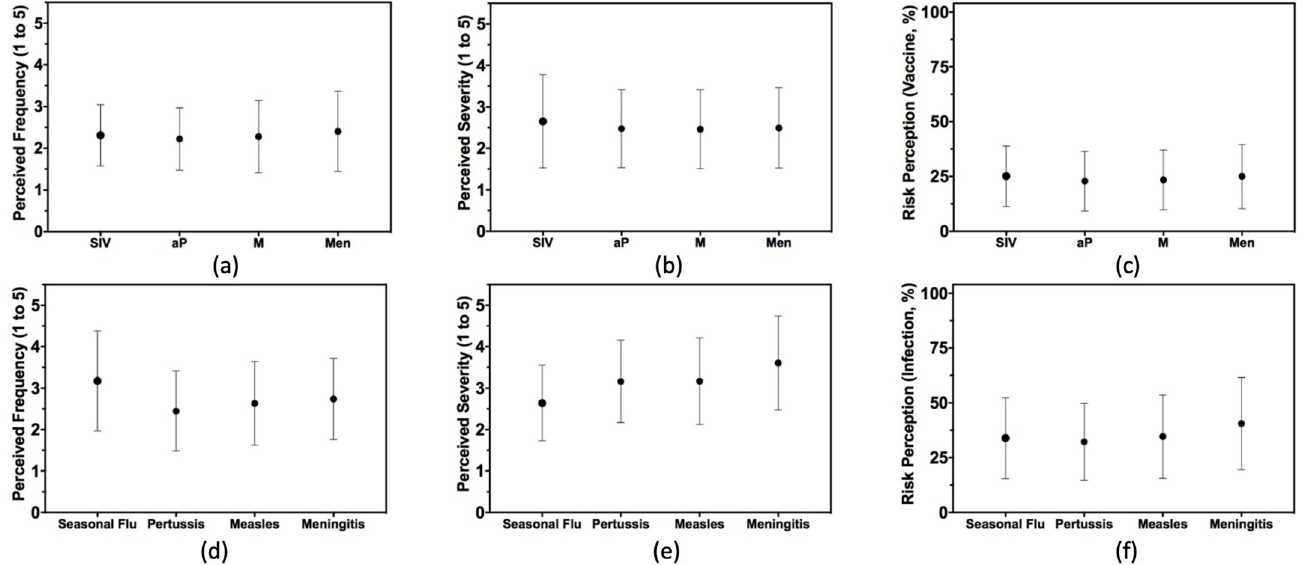
Figure 3. Risk perception component for 161 first responders from the Province of Parma (2018) participating in our survey. Participants were questioned on four vaccine-preventable disorders (i.e., seasonal influenza, pertussis, measles, meningococcal meningitis), focusing on the perceived frequency and severity of both vaccine side effects and natural infection. Respective risk perception scores for natural infection and vaccine side effects were calculated as the product of the perceived frequency and severity of the events (Note: SIV = Seasonal Influenza Vaccine, aP = Pertussis vaccine, M = measles vaccine, Men = meningitis vaccine; Subfigures: ( a ) = perceived frequency of vaccine side effects; ( b ) = perceived severity of vaccine side effects; ( c ) = risk perception score for vaccinations; ( d ) = perceived frequency of natural infections; ( e ) = perceived severity of natural infections; ( f ) = risk perception score of natural infections).